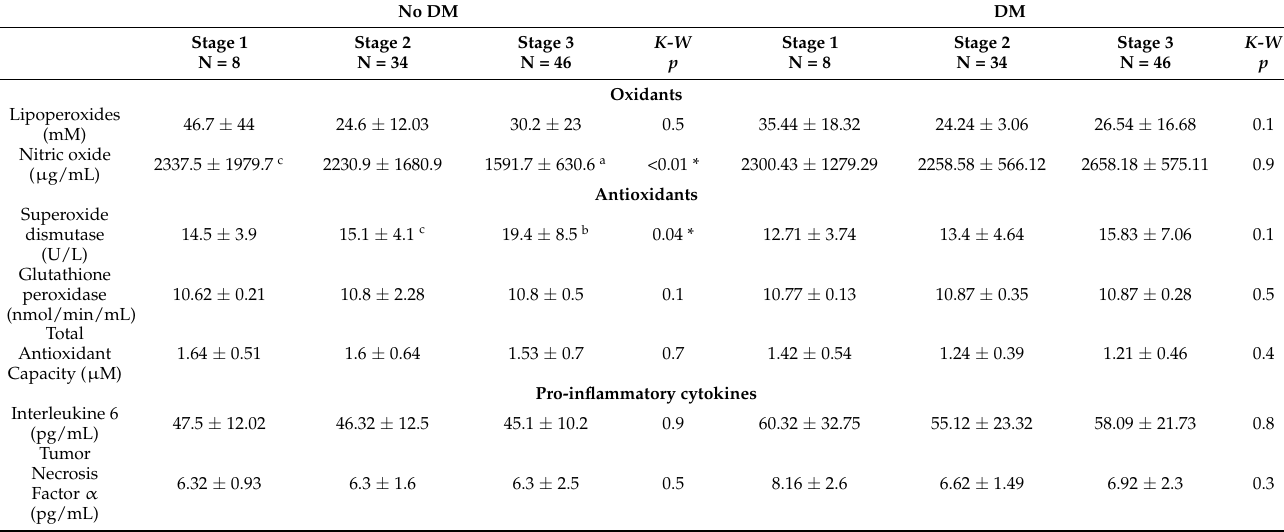
Table 2. Inflammatory and oxidative stress markers.